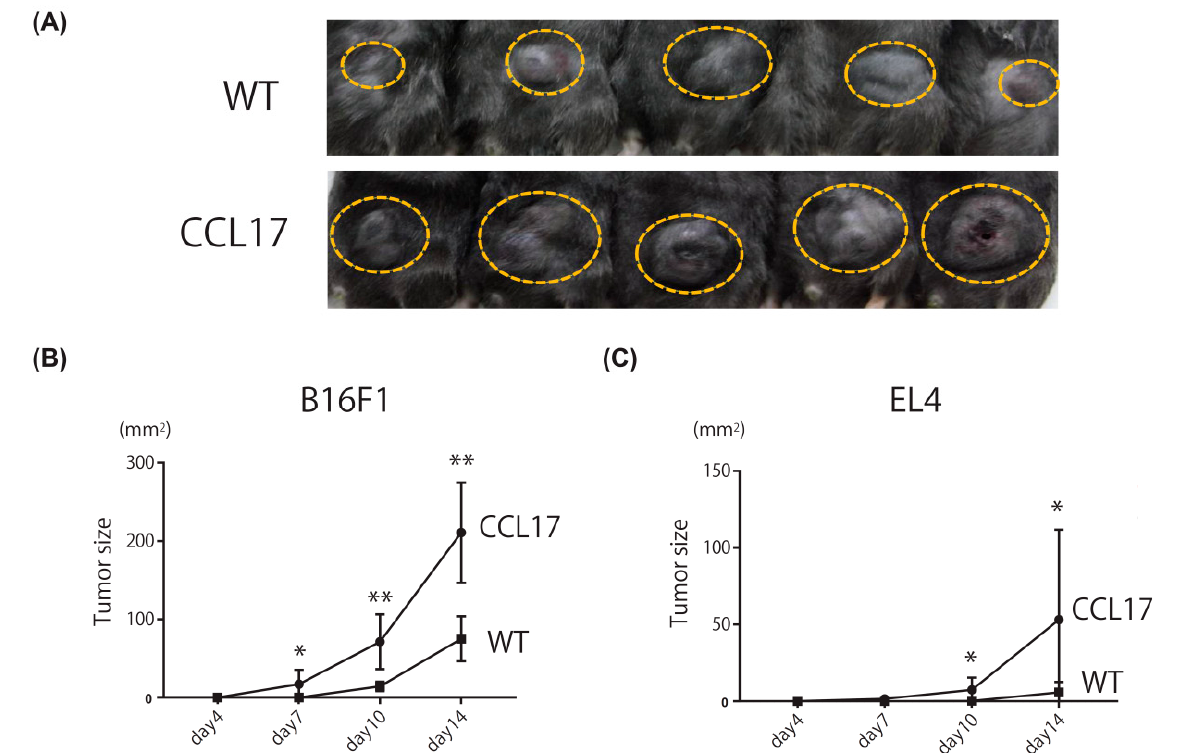
Figure 1. Tumor formation of back skin was enhanced in CCL17 TG mice. Shaved back skin of wild-type (WT) and CCL17 transgenic (TG) mice was treated with injection of B16F1 cells or EL4 cells. The tumor size was calculated using the equation: L1 × L2, where L1 = longest diameter (mm) and L2 = shortest diameter (mm) and evaluated on days 4, 7, 10, and 14. ( A ) Phenotypical manifestation of back skin from WT and CCL17 TG mice 14 days after B16F1 cells injection (yellow circle). ( B ) Tumor sizes were significantly increased in CCL17 TG mice compared with those in WT mice on days 7, 10, and 14 after subcutaneous injection of B16F1 cells. ( C ) Tumor formation was also significantly promoted in CCL17 TG mice compared with that in WT mice on days 10 and 14 after injection of EL4 cells. Data are presented as mean ± SEM of three independent experiments ( n = 6 for each group). * p < 0.05, ** p < 0.01, versus WT mice.